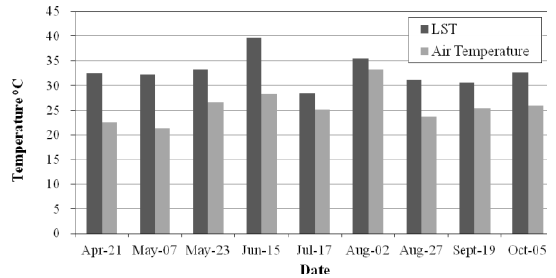
Figure 4. Comparison of LST and the Air Temperature for the Trail Road Landfill in 2007